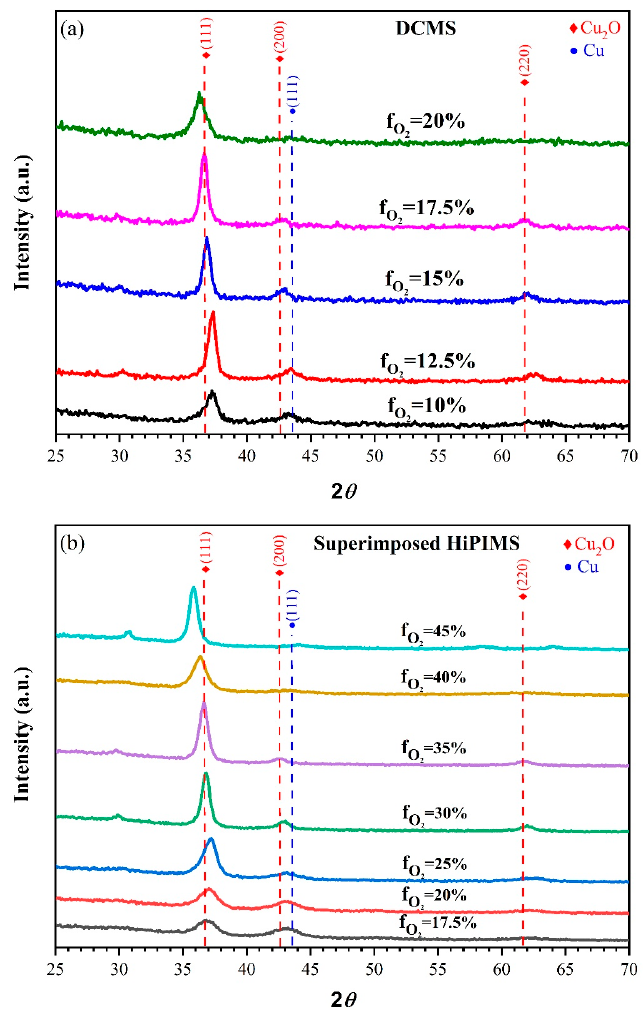
Figure 1. X-ray diffraction spectra of Cu 2 O films deposited by ( a ) DCMS and ( b ) superimposed Figure 1. X-ray di ff raction spectra of Cu 2 O fi lms deposited by ( a ) DCMS and ( b ) superimposed HiPIMS at di ff erent oxygen fl ow rates. HiPIMS at different oxygen flow